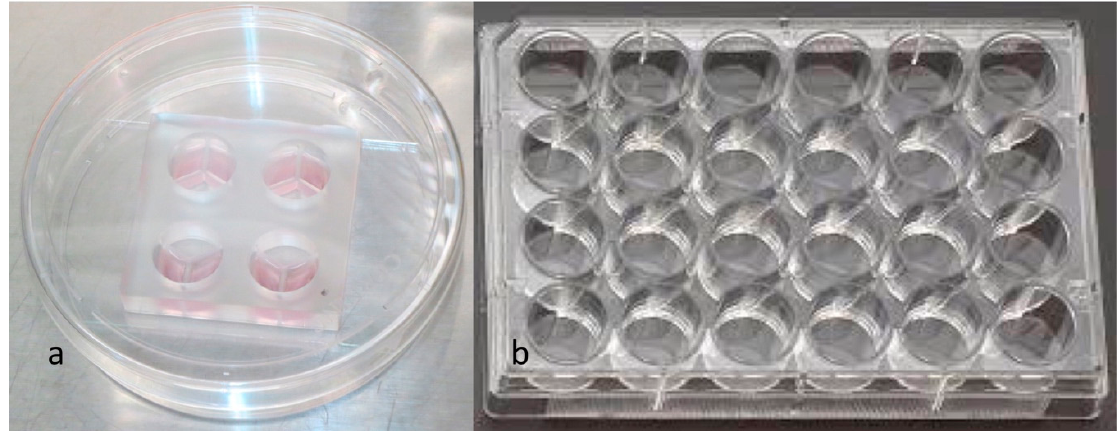
Figure 4. ( a ) 3-chamber co-culture device. ( b ) Conventional 24-well culture plate. Statistical